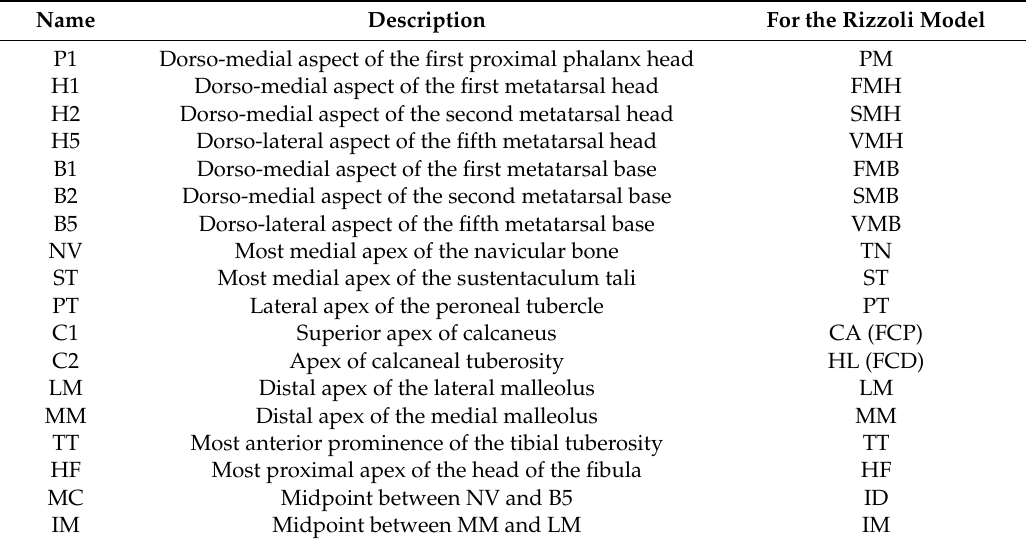
Figure 1. The process flow chart. Table 1. Marker location of our new model and marker name corresponding to the Rizzoli model.